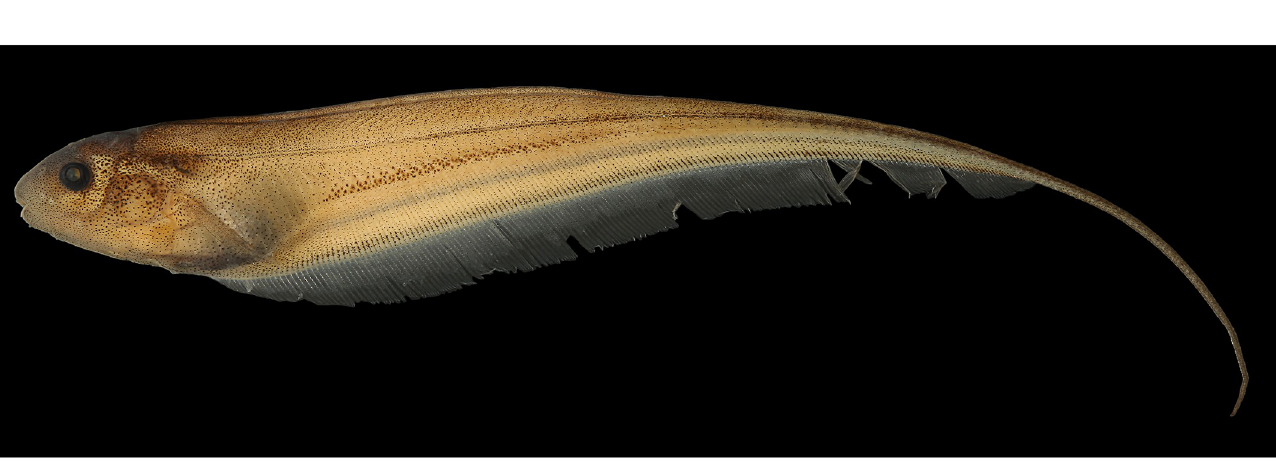
PLOS ONE | https://doi.org/10.1371/journal.pone.0220287 August 14,